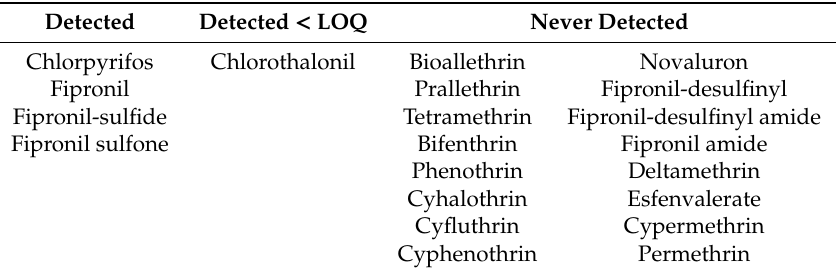
Table 3. Target Compound Results via GC-Q / TOF-MS.